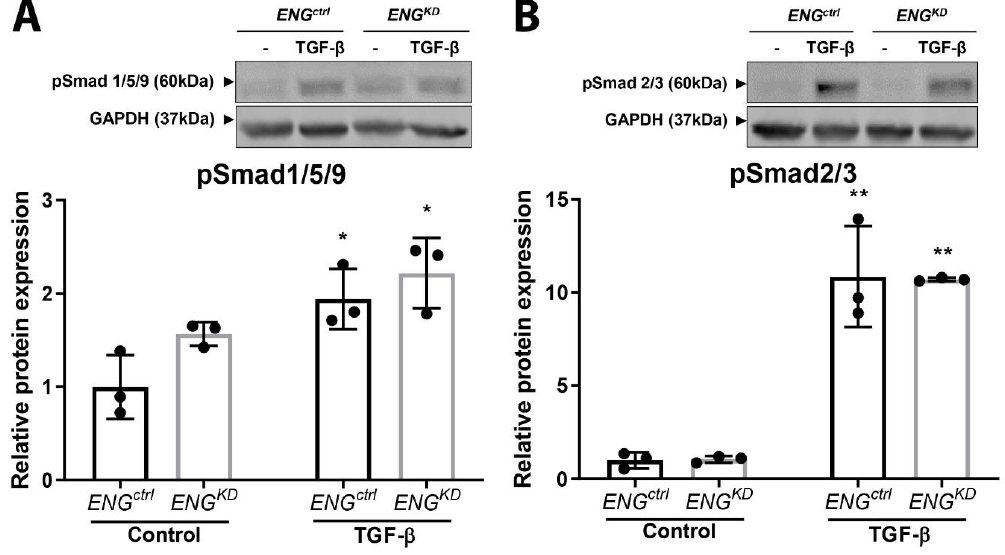
Figure 7. TGF- β -induced Smad1 / 5 / 9 and Smad2 / 3 phosphorylation is similar in ENG KD and ENG ctrl fibroblasts. ENG ctrl and ENG KD fibroblasts were incubated with 5 ng / mL TGF- β 1 for 1 h, after which pSmad1 / 5 / 9 ( A ) and pSmad2 / 3 ( B ) were measured using western blot analysis. GAPDH was used as a loading control. The lower graphs show the quantification of the western blot data. pSmad protein levels were plotted relative to unstimulated ENG ctrl fibroblasts, and summary data are presented as the mean ± SD from three experiments. * p < 0.05 and ** p < 0.01 versus unstimulated fibroblasts from the same cell line. (Student’s t